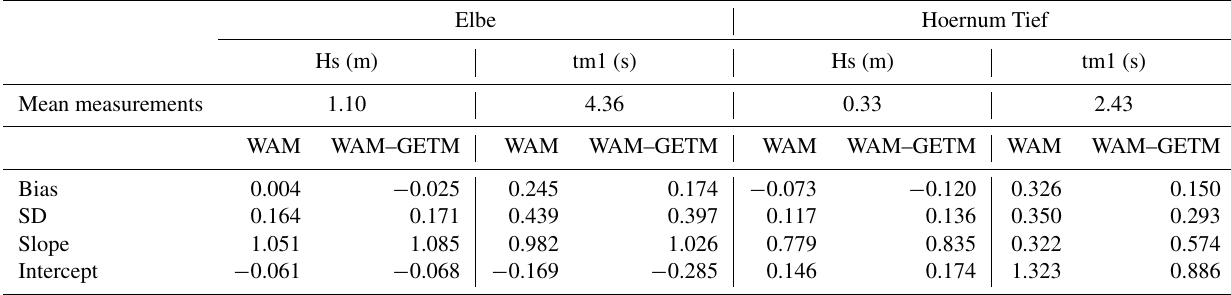
Table 2. Elevation amplitude (cm) RMSE and mean errors (model–observations) for the coupled wave–circulation model and GETM-only model for the tide gauge data from British Oceanographic Data Centre (BODC) over the German Bight area.